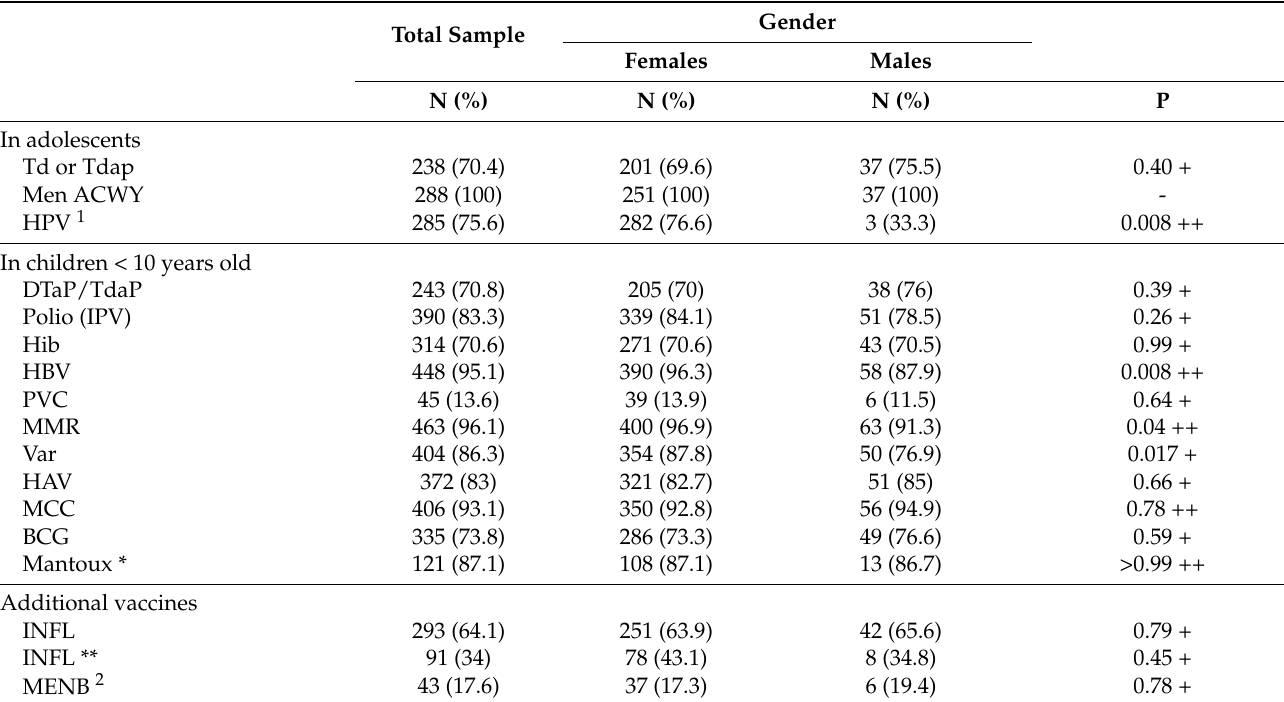
Table 4. Percentages of fully vaccinated participants in each vaccine, in total sample and by gender. Gender Total Sample Females Males N (%) N (%) N (%)